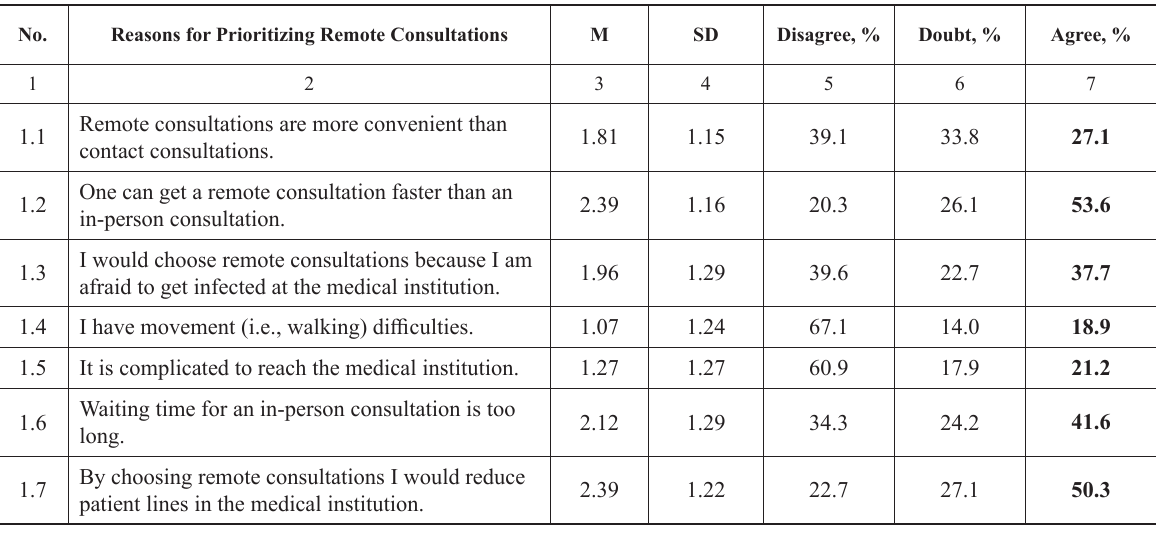
Table 3. Rating of Reasons Determining Why Patients with Chronic Rheumatic Diseases Would Choose Remote Consultations